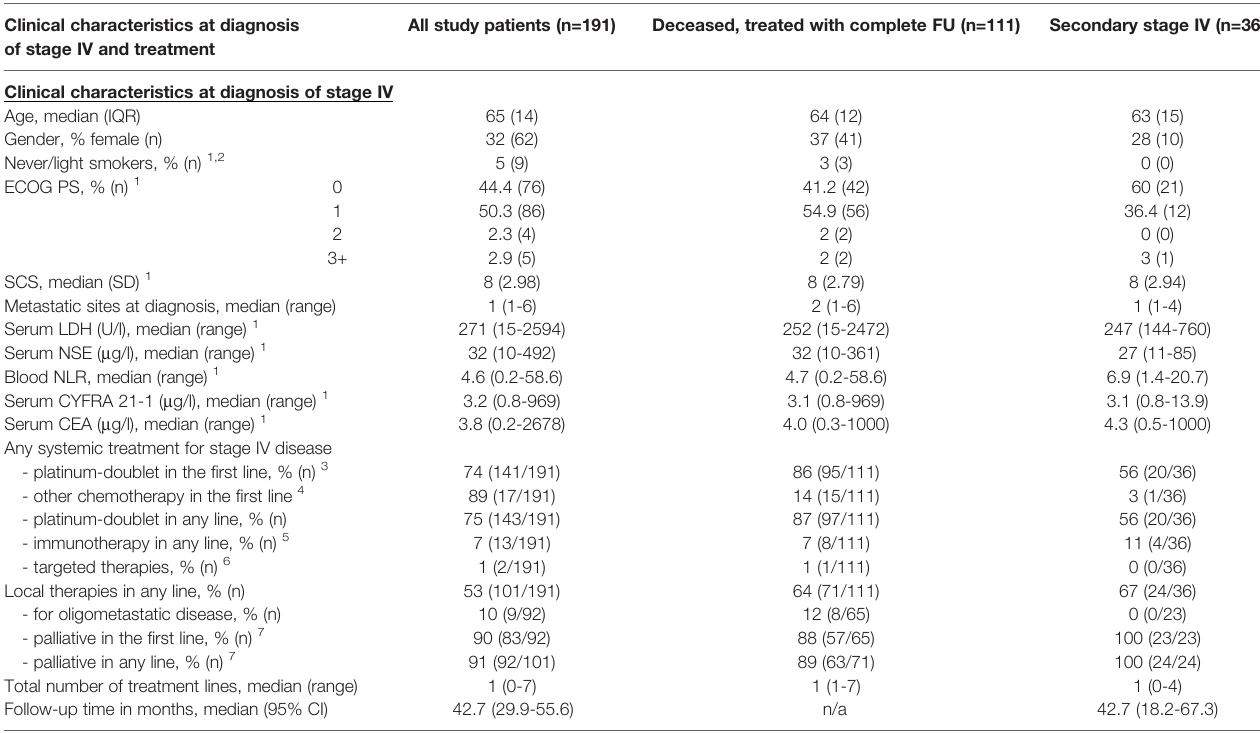
TABLE 1 | Patient